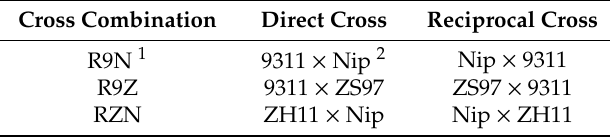
Table 5. The detail information of three reciprocal